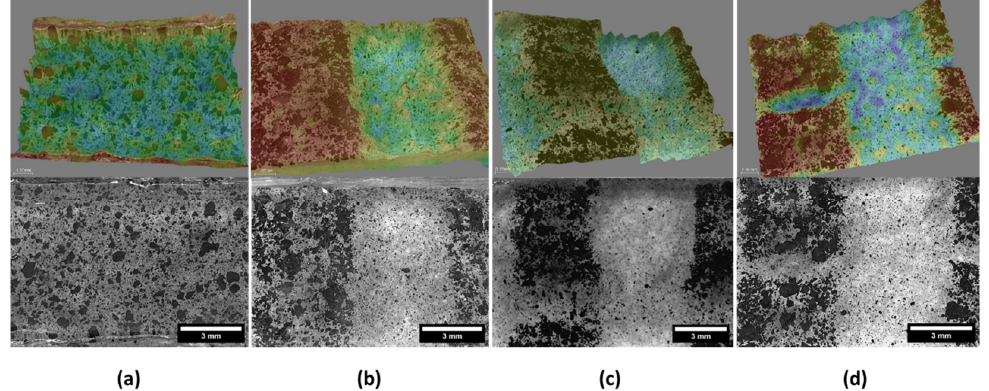
Figure 9. Magnetic patterns and 3D reconstruction of the samples ( a ) randomly distributed, ( b ) magnetic pattern with alternate polarity, ( c ) magnetic pattern with Halbach array, and ( d ) magnetic pattern with the same polarity.